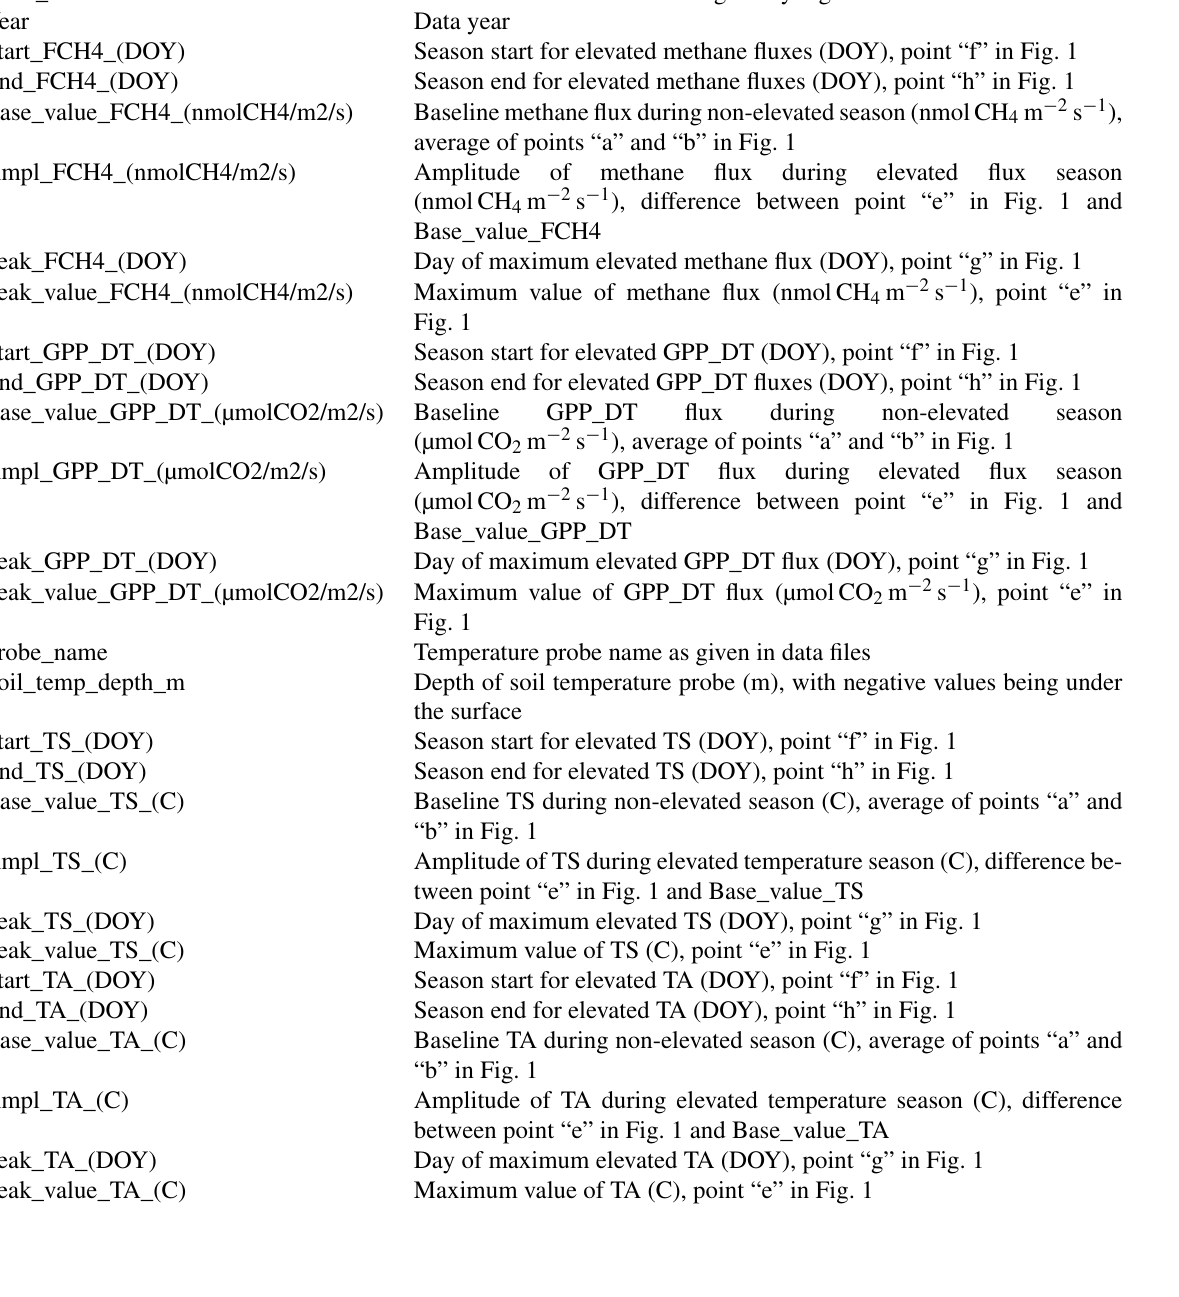
Baseline TA during non-elevated season (C), average of points “a” and “b” in Fig. 1 Amplitude of TA during elevated temperature season (C), difference between point “e” in Fig. 1 and Base_value_TA Day of maximum elevated TA (DOY), point “g” in Fig. 1 Maximum value of TA (C), point “e” in Fig.